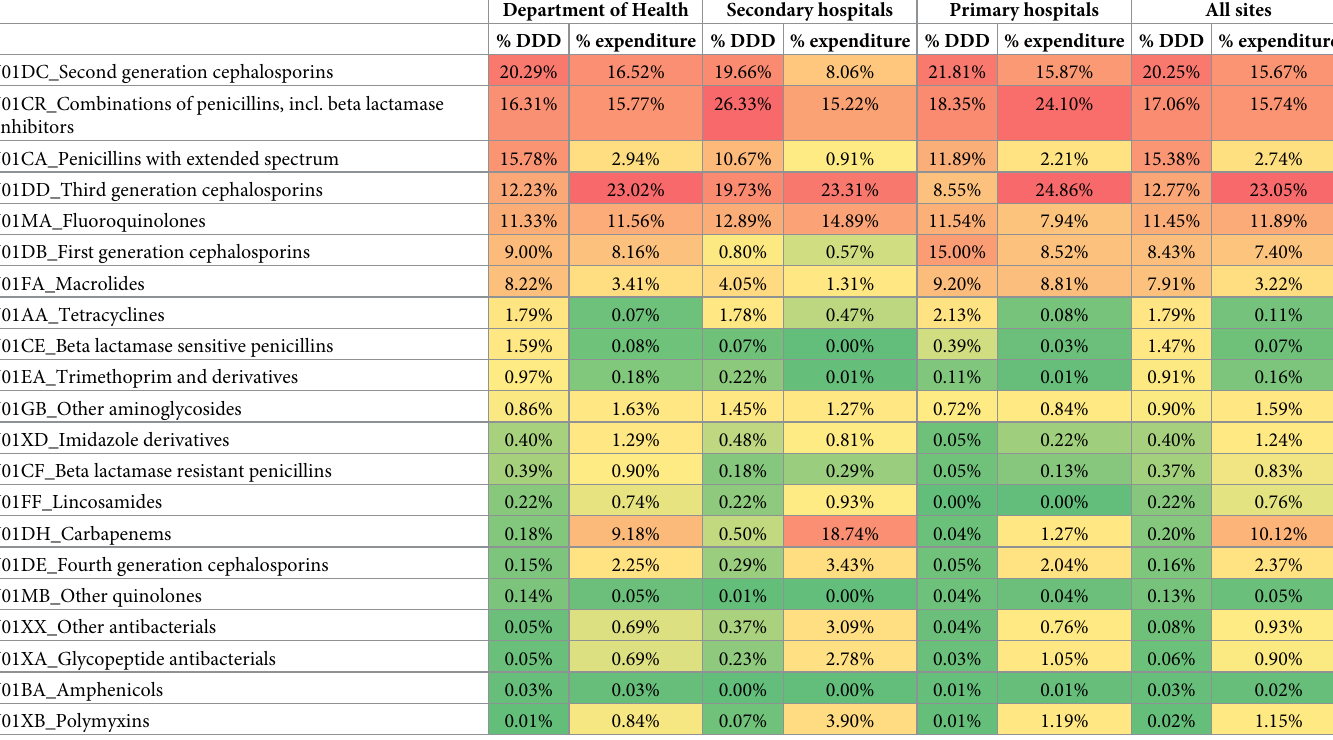
Table 2. The proportions of total DDD and expenditure of antibacterials for systemic use (J01).